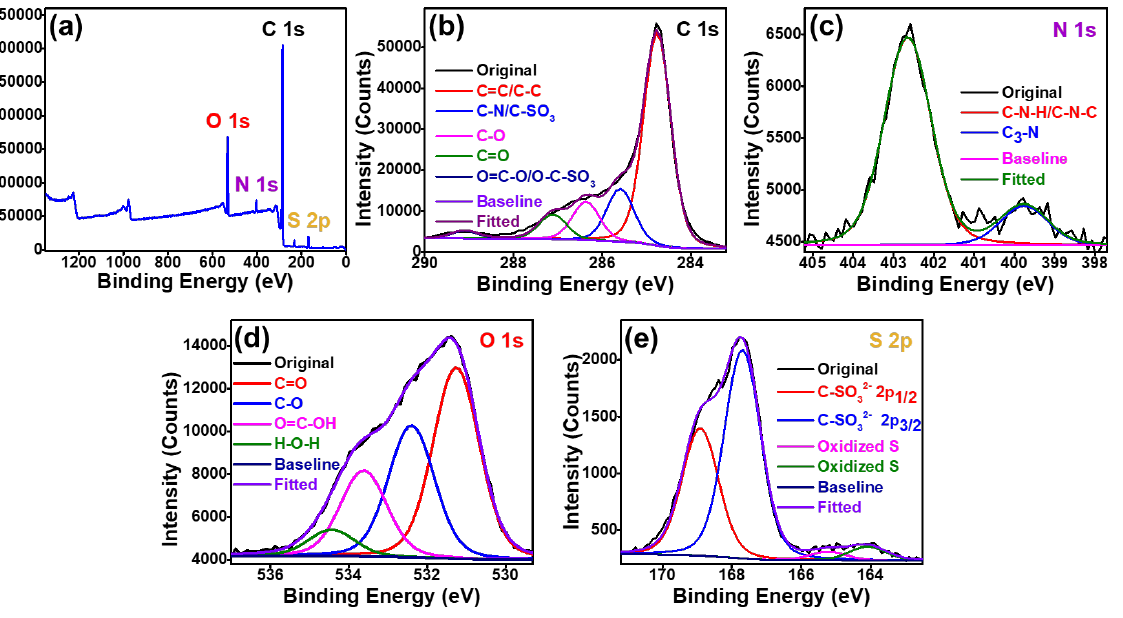
Figure 5. XPS spectra of GPSB: ( a ) survey spectra, ( b ) C 1s, ( c ) N 1s, ( d ) O 1s, and S 2p ( e ).